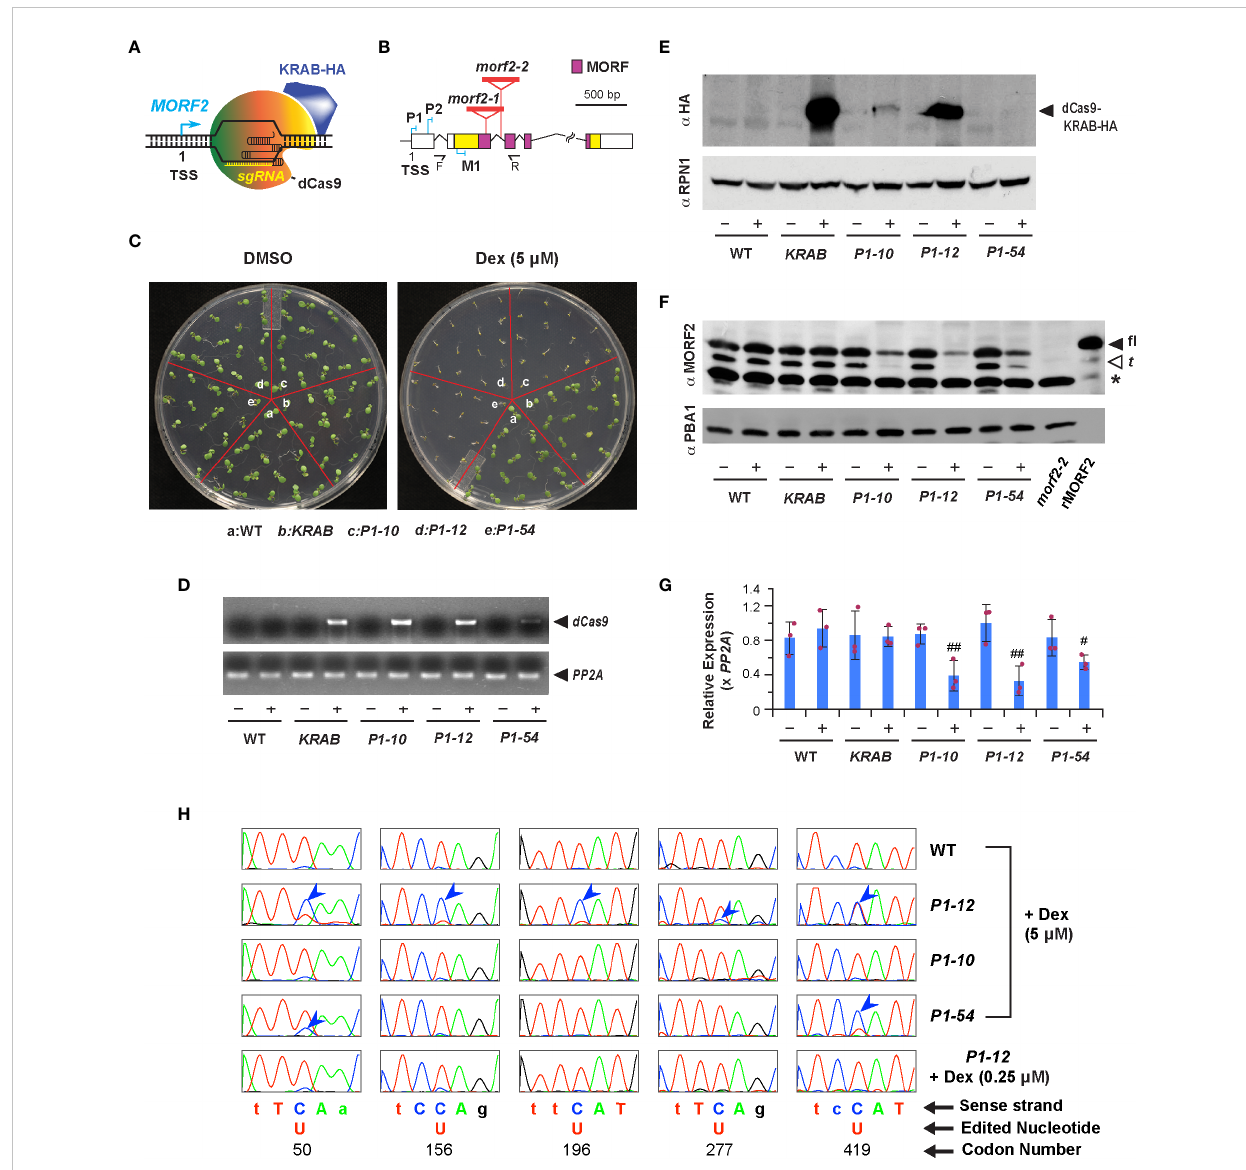
FIGURE 1 Downregulation of MORF2 by iCRISPRi inhibits plant growth prior to in fl uencing RNA editing in chloroplasts. (A) A diagram showing the binding of dCas9-KRAB and sgRNA to the MORF2 locus. TSS: transcription start site. (B) Schematic representation of the MORF2 locus. Folded lines indicate introns, and the colored and white boxes represent coding and untranslated regions, respectively. Regions encoding the MORF domain are pink colored. Red triangles locate the T-DNA insertion sites for the morf2-1 and morf2-2 alleles. P1, P2, and M1 indicate the position of three protospacers. F and R represent the site of forward and reverse primers, respectively, used in combination with LBa1 (a left border primer of the T- DNA) for con fi rming the homozygous morf2-2 allele by PCR. Primer sequences are listed in Table S1. (C) Growth phenotypes of 7-d-old seedlings grown under LD on 1/2 MS media supplemented with 0.1% DMSO (DMSO hereafter) or 0.1% DMSO plus 5 m M Dex (5 m M Dex hereafter). (D) sqRT- PCR identi fi es an induced expression of dCas9 only in the indicated transgenic plants treated with 5 m M Dex as shown in (C) . – and + indicate DMSO and 5 m M Dex treatments, respectively, herein as well as in (E-G) . (E) Immunoblot analysis showing the detection of dCas9-KRAB-HA fusion in KRAB , P1-10 , and P1-12 seedlings treated with 5 m M Dex as shown in (C) . A proteasome subunit, RPN1, was used as a control indicating nearly equal protein loading. (F) Dex treatment reduced protein products of MORF2 in three P1 transformants but not in KRAB . Protein extracts from 7-d-old morf2-2 seedlings and E. coli cells expressing recombinant MORF2 (rMORF2) were used as negative and positive controls showing the absence and presence of MORF2, respectively. The full-length ( fl ) and truncated (t; putatively processed by peptidases) MORF2 are indicated by the closed and open arrowheads, respectively. The asterisk identi fi es an unknown cross-reacting species. A proteasome subunit, PBA1, was used as a control indicating nearly equal protein loading. (G) qPCR analysis of MORF2 transcripts in 7-d-old seedlings treated with or without 5 m M Dex as shown in (C) . Relative expression of MORF2 is normalized to one of the three WT biological replicates treated with DMSO. PP2A shown in this fi gure and in Figures 2E, 3E, 7 was used as reference standards. Bars represent mean ( ± SD) from three biological replicates, each with three technical replicates. The maroon dots indicate three data points of replicates in each bar. # and ## indicate statistically signi fi cant differences between the two treatments within the same genotype (Student ’ s t -test, P < 0.05 and 0.01, respectively). (H) Comparison of sequencing chromatograms containing fi ve indicated editing sites in the transcripts of ndhB gene obtained from 7-d-old light grown seedlings as indicated. Blue arrowheads point to the cytidine sites with lower editing ef fi ciencies to uridine compared to WT. Genetic codons containing an editing site are capitalized and